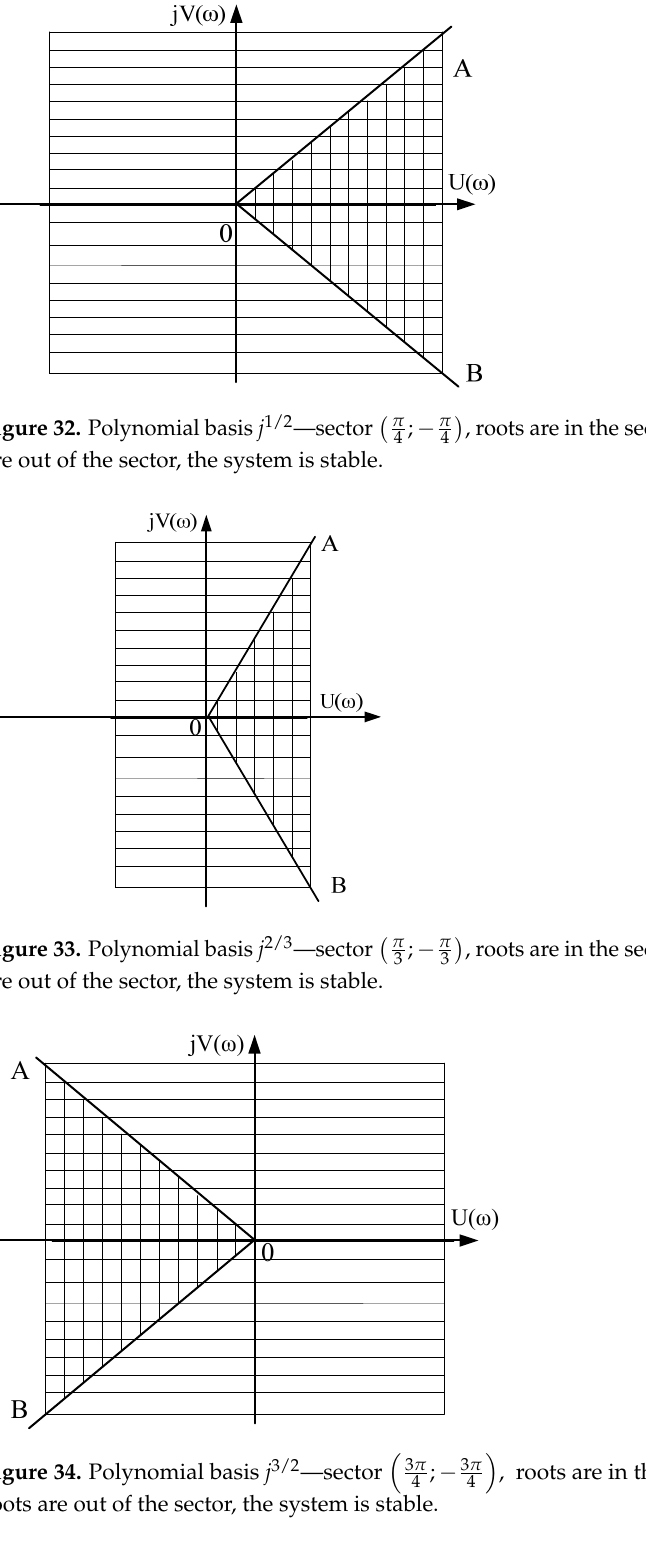
Figure 34. Polynomial basis j 3/2 —sector (cid:4672) 𝟑𝝅 roots are out of the sector, the system is stable.